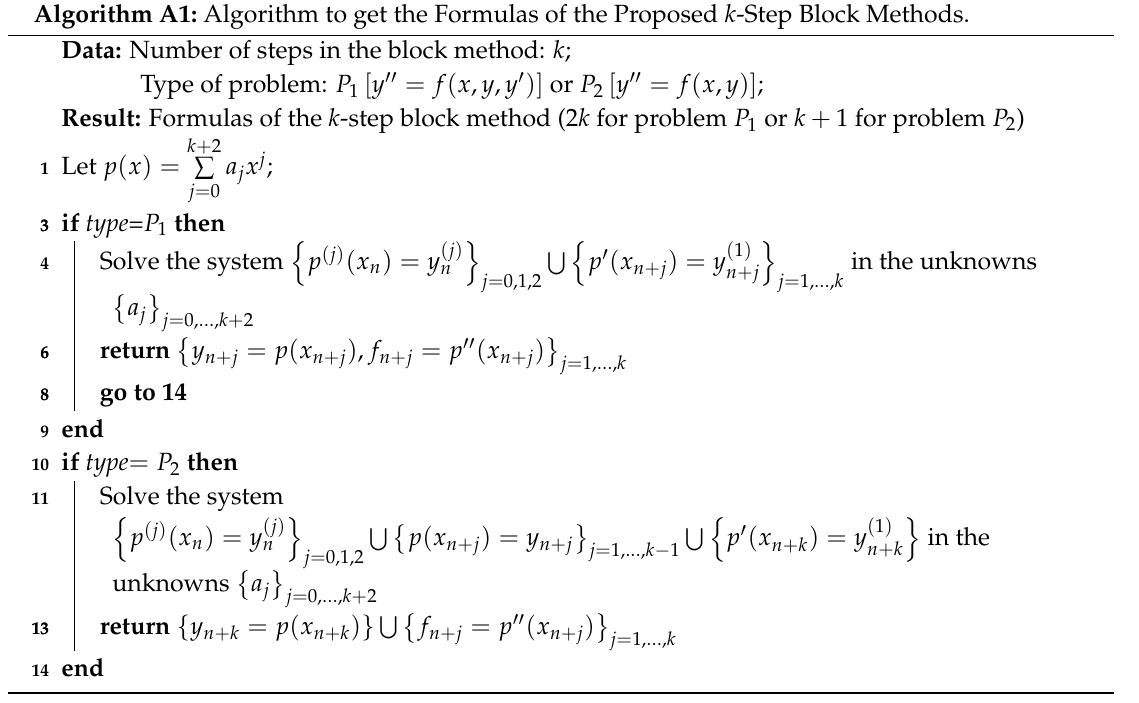
Algorithm A1: Algorithm to get the Formulas of the Proposed k -Step Block